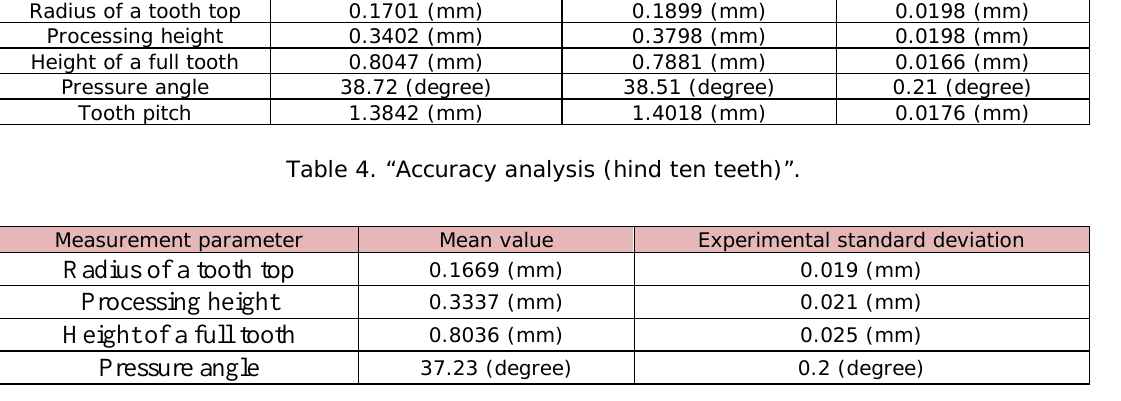
Table 5. “Mean value and experimental standard deviation of measurement